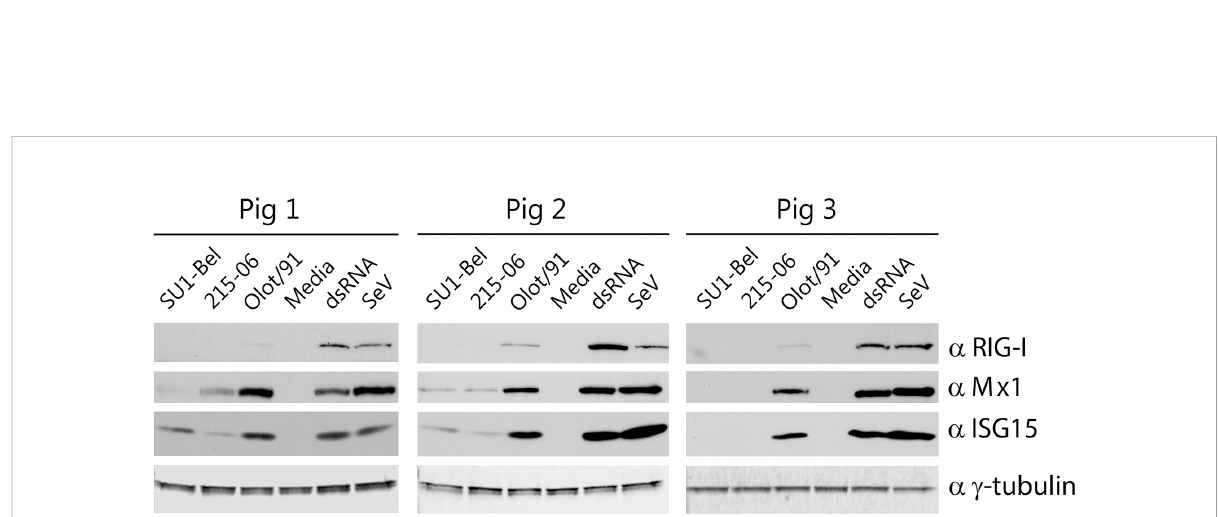
FIGURE 4 Olot/91 induces higher expression of interferon stimulated genes compared with virulent PRRSV-1 strains. BMDM from three pigs were inoculated with SU1-Bel, 215-06, Olot/91 (MOI 0.01), untreated (media) or stimulated with dsRNA or Sendai Virus for 48 h, then whole cell lysates were analyzed by Western blot using antibodies against RIG-I, Mx1, ISG-15 or g -tubulin to con fi rm equal